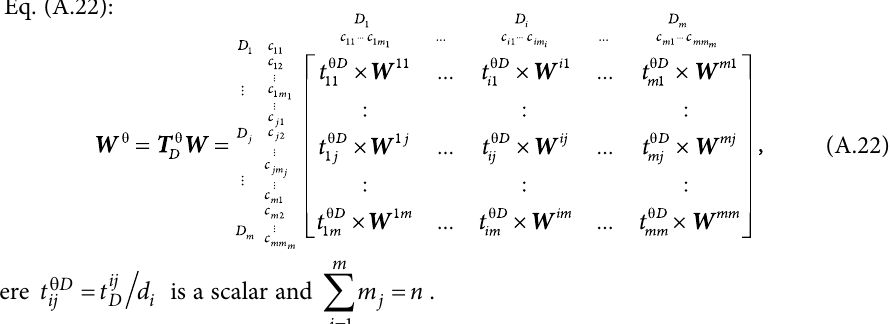
Stage 4: Comparing the performance gap values with a modified-VIKOR